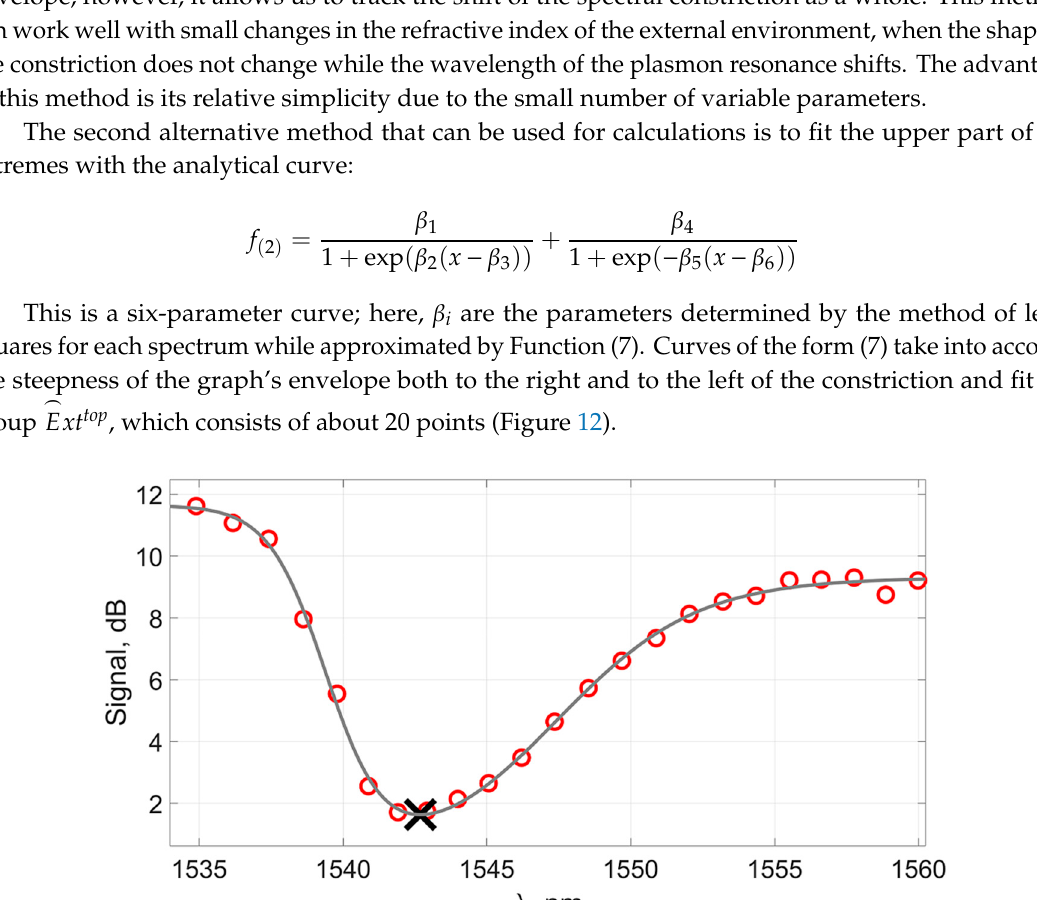
fitting this subgroup, and its minimum